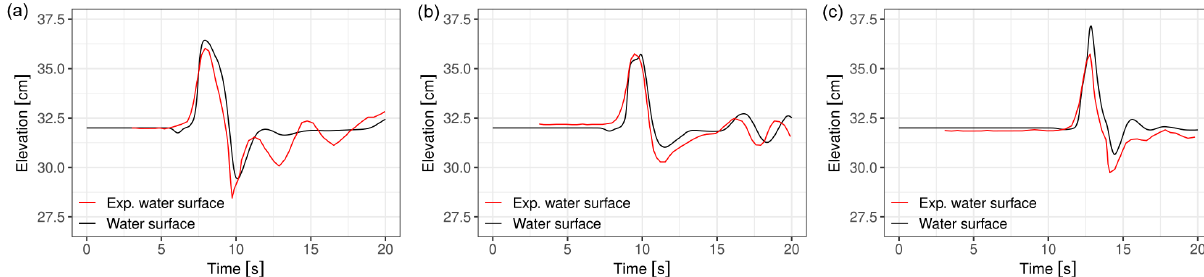
Figure 11. Simulated and experimental results of unsteady flow over an island for gauges G9 (a) , G16 (b) , and G22 (c) .